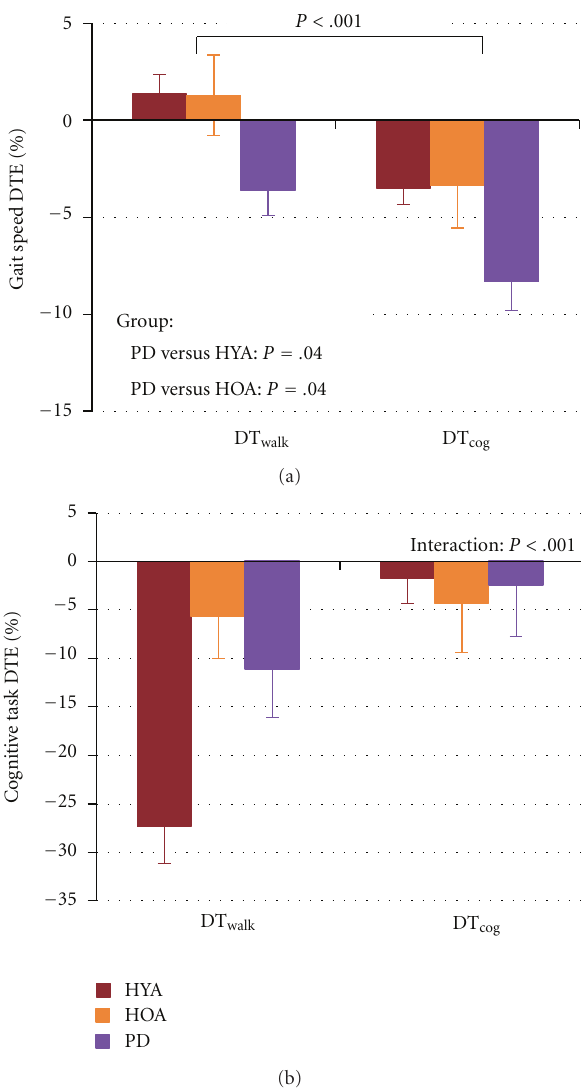
Figure 2: The e ff ects of instructions on walking DTEs (a) and composite cognitive task DTEs (b) for the healthy young adults (red bars), healthy older adults (orange bars), and people with PD (purple